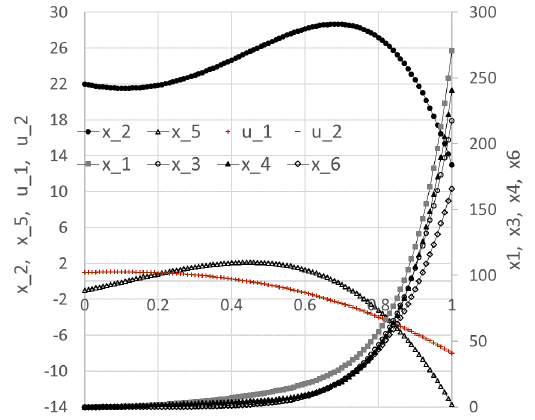
Figure 16. Initial trajectories for optimal control problem (17)–(29) based on default values shown in Figure 14. Table 3. Formulas definitions used for solving optimal control problem (17)–(29).